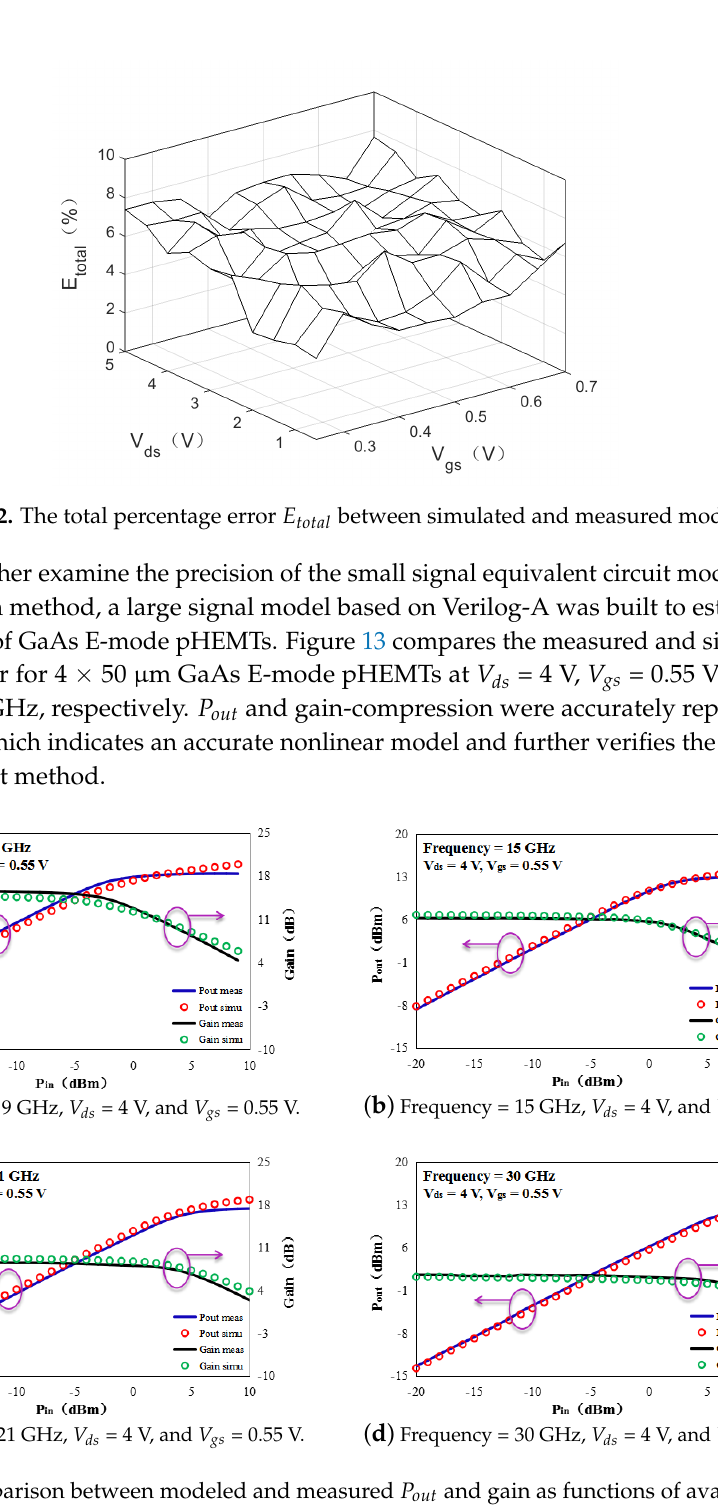
Figure 13. Comparison between modeled and measured P out and gain as functions of available input power ( P in ) for V ds = 4 V and V gs = 0.55